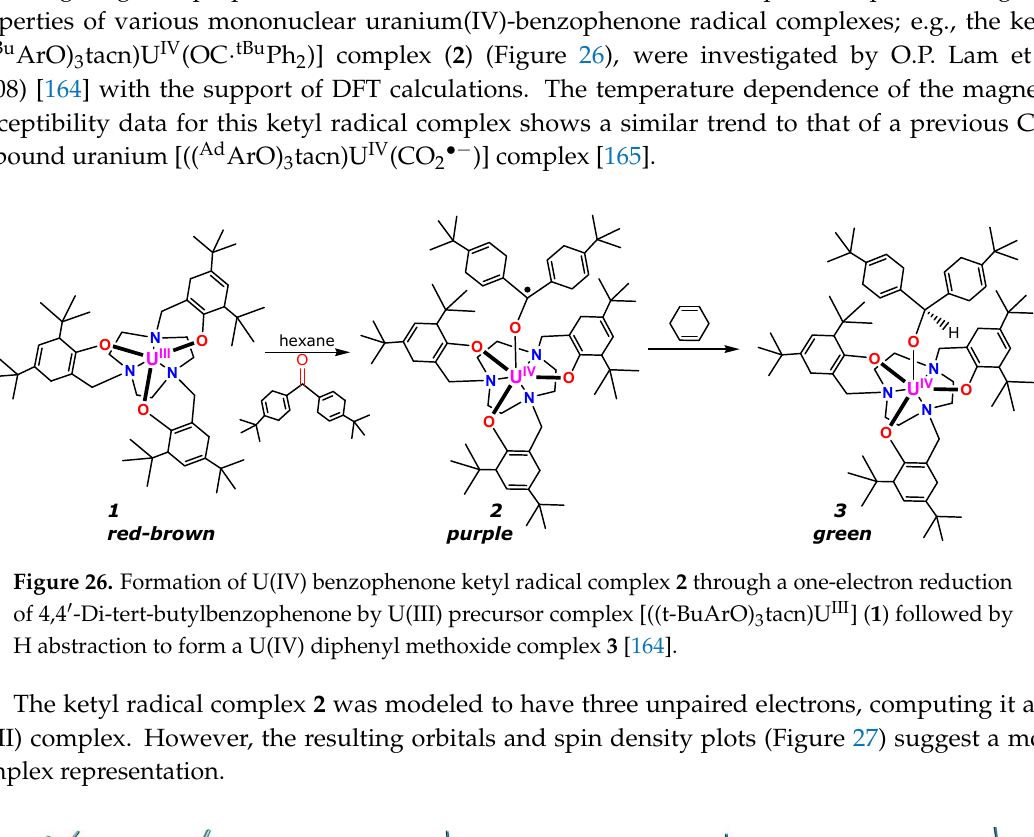
Figure 25. spin-density plot of the [U(L)] 2 Q OMe . Plot surfaces displayed with an iso-value of 0.02 au (reprinted with permission from [156], the Royal Society of Chemistry, 2017).